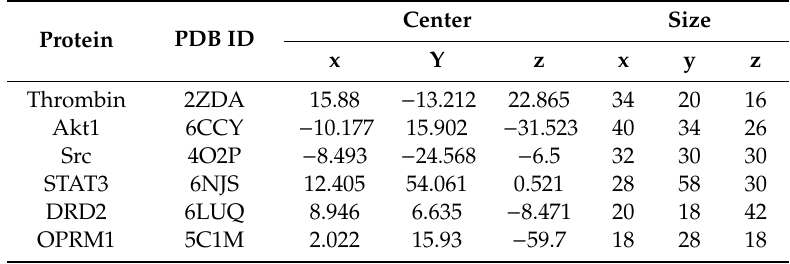
Table 1. The parameters of the molecular docking simulations used in this